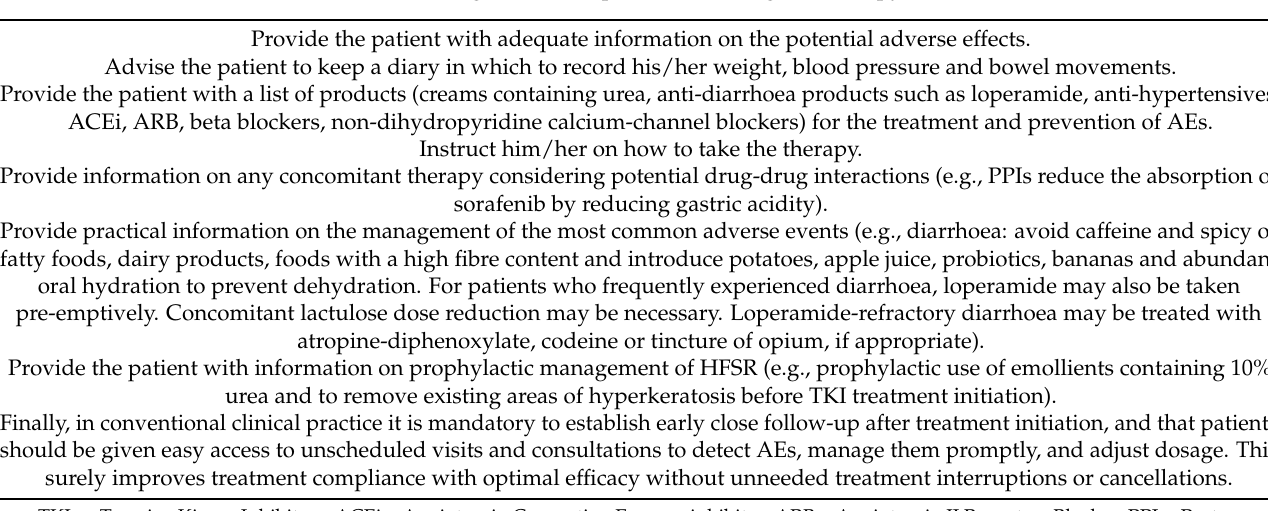
Table 4. Essential guidance for patients initiating TKI therapy